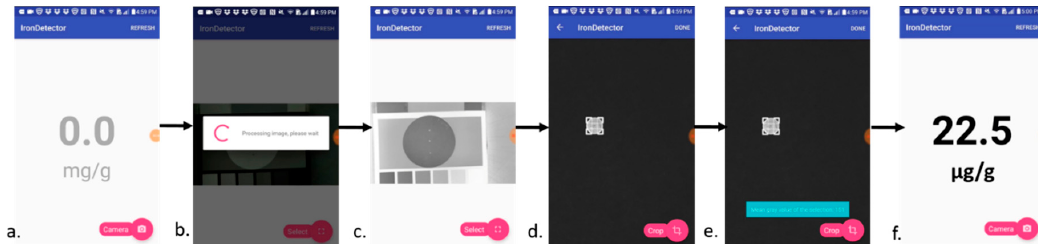
Figure 6. Screenshots of the Nu3px app analysis flowchart. ( a ). Home screen upon opening app. ( b , c ). After the user takes a photo within the app, the app automatically processes the image (i.e., converts image to 8-bit grey scale, invert). ( d ) The user selects the detection zone using a pinch and drag circle focus. ( e ) The app measures the mean grey pixel value. Steps ( d , e ) can be repeated for replicates. ( f ) Once the user has measured all the replicates, the app applies the calibration curve algorithm and averages the result between the x number of replicates for a final output in the desired concentration correcting for dilution.